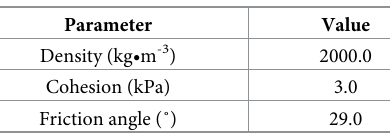
Table 3. Soil parameters.